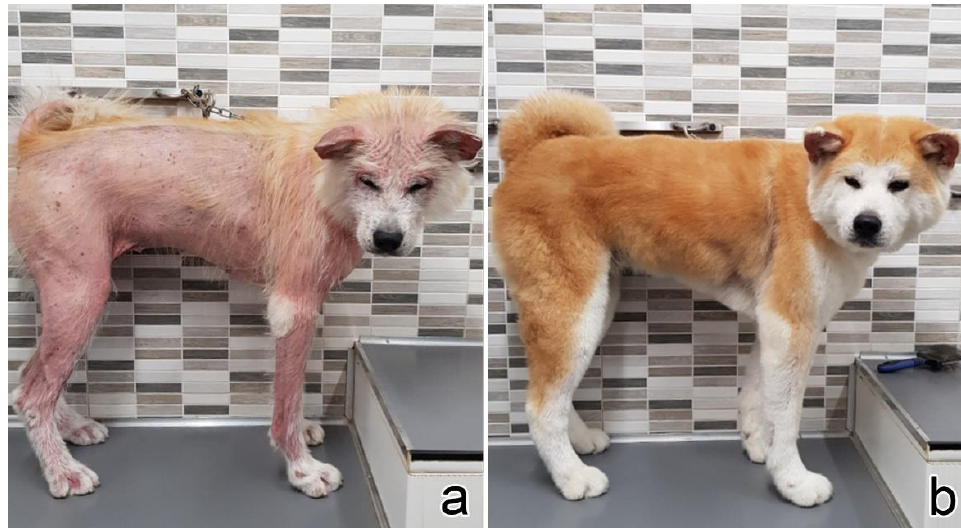
Figure 5. Clinical follow up of dog no. 9. ( a ) The dog at presentation: severe generalized erythema- tous and exfoliative dermatitis. ( b ) The dog at 11-month follow-up after removal of all drugs: relevant improvement of clinical signs with almost complete hair regrowth (courtesy Dr. Roberto Dami- ani).